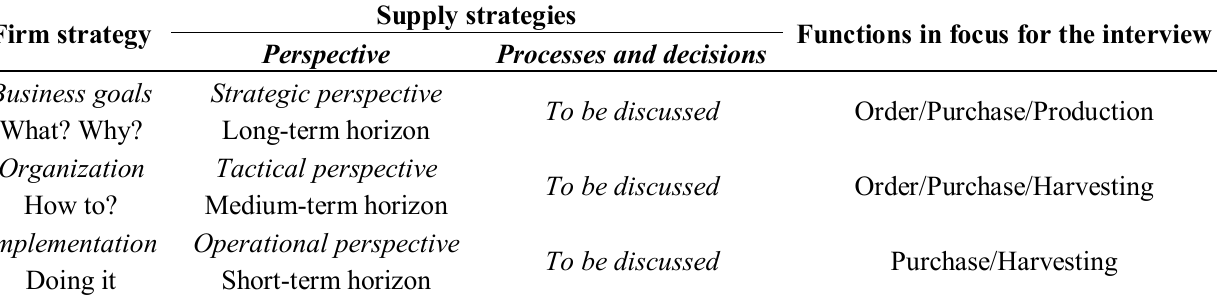
Table 2. The generic framework used for interview discussions. Based on Nollet et al.